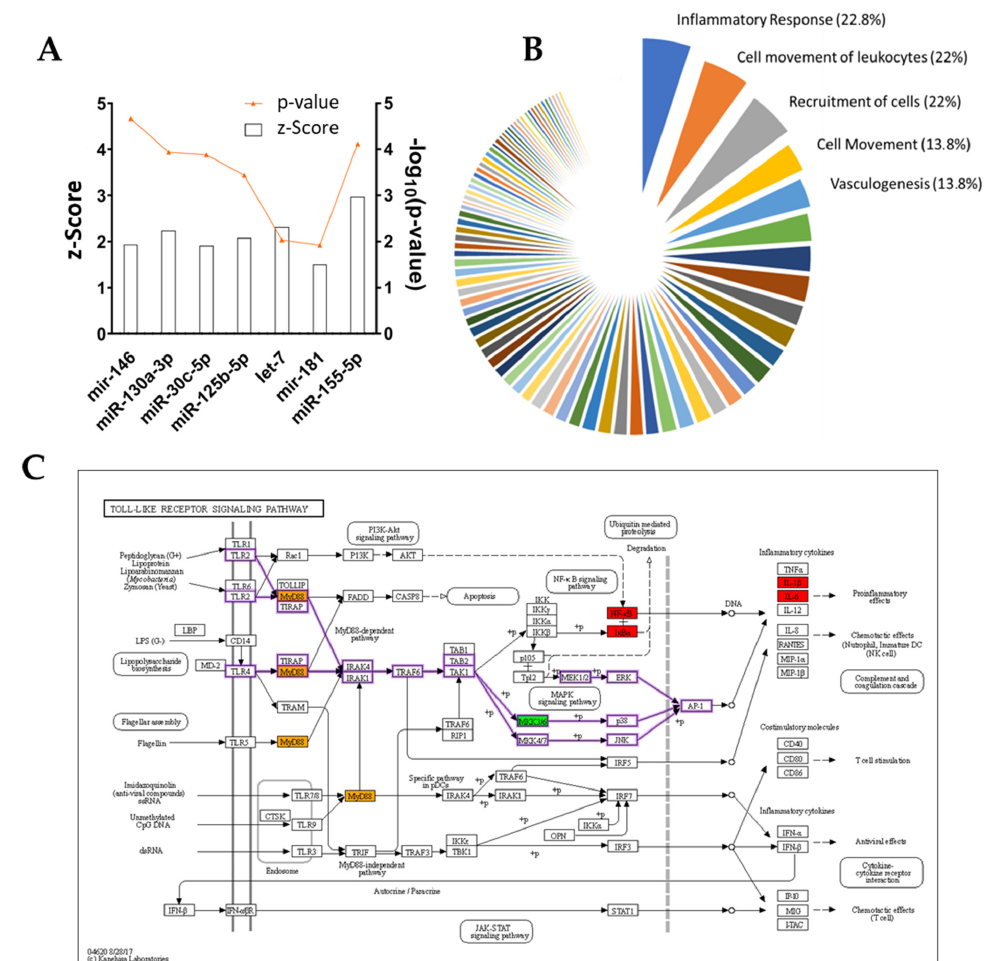
Figure 8. ( A ) Upstream miRNA regulators for w/ TNF α IPA analysis, z-Score and p -value are shown. ( B ) IPA regulator’s ranked by influenced functions, shown as percentage of the total regulator effects. ( C ) KEGG pathway: Toll-like receptors signaling pathway, with color-coded protein slots corresponding to DEGs expression. This network comprises 20 downstream DEGs (ADM, CSF3, CXCL2, CXCL3, EDN1, IL1A, IL1B, IL6, INHBA, MMP9, MYD88, NFKB2, NFKBIA, NFKBIZ, PTGES, PTGS2,